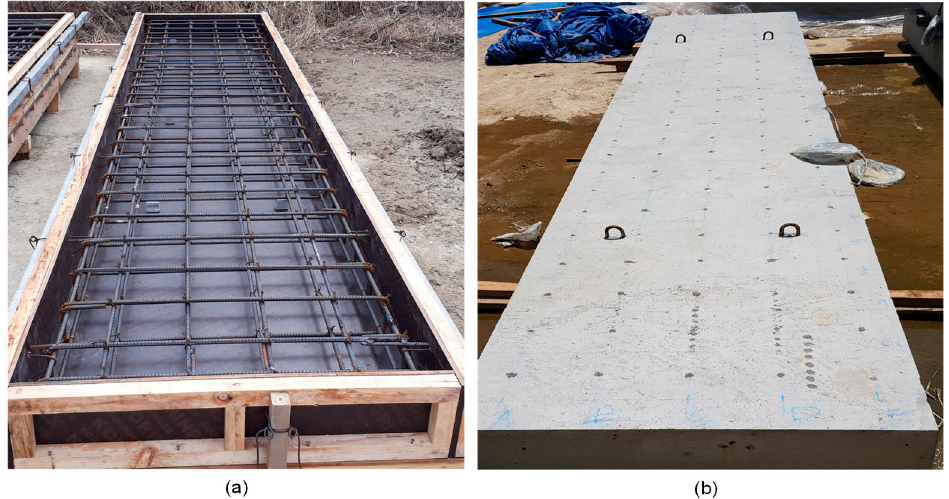
Figure 3. Photo of the reinforced concrete slab specimen in this study: ( a ) reinforcing steel cage in a wooden form before casting concrete and ( b ) hardened concrete slab specimen.